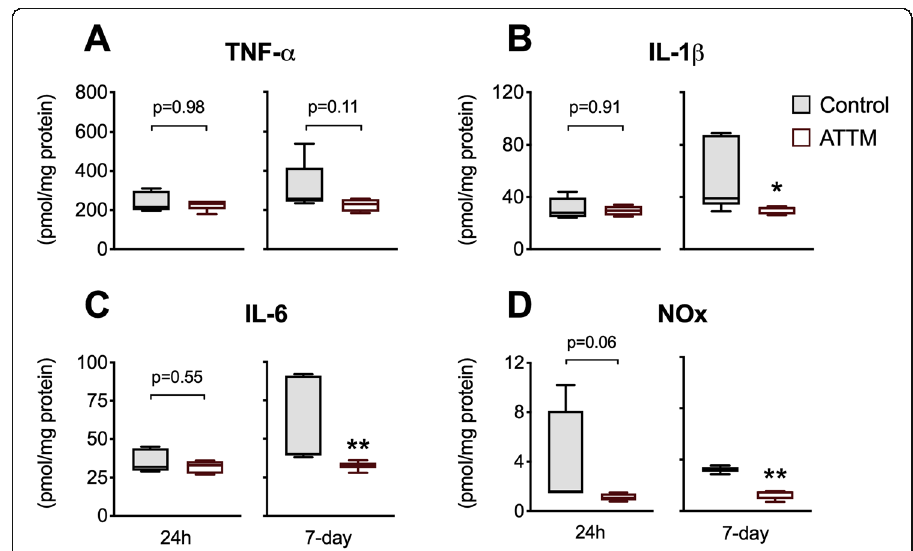
Fig. 6 Pro-inflammatory markers. Panels a – d depict TNF- α , IL-1 β , IL-6, and total nitric oxide (NOx) products, respectively. n = 5 per group. * p < 0.05, ** p < 0.01 vs controls, unpaired T